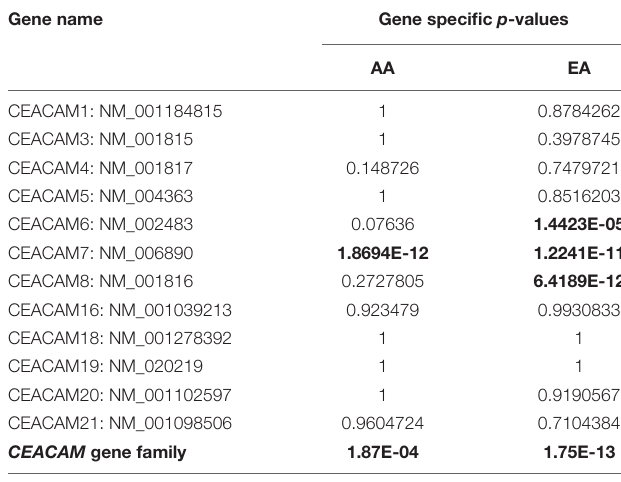
TABLE 5 | Aggregation analysis for rare ( < 1% MAF) PTVs in the CEACAM gene